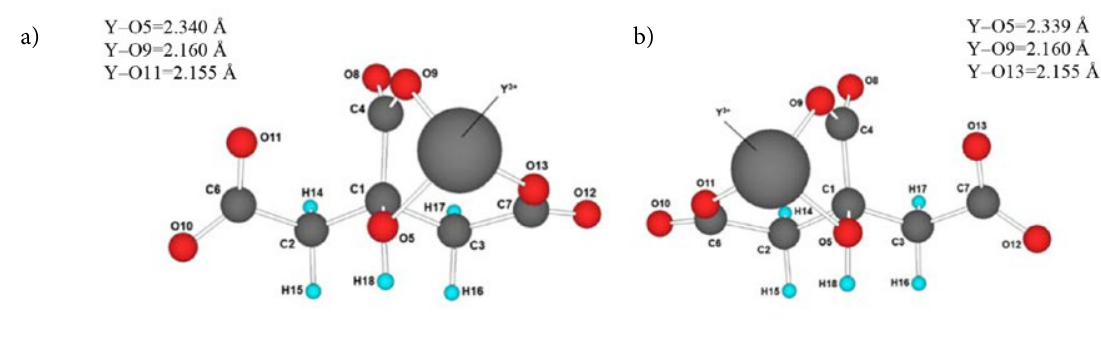
Fig. 4. Optimized structure of the most stable Y–CA